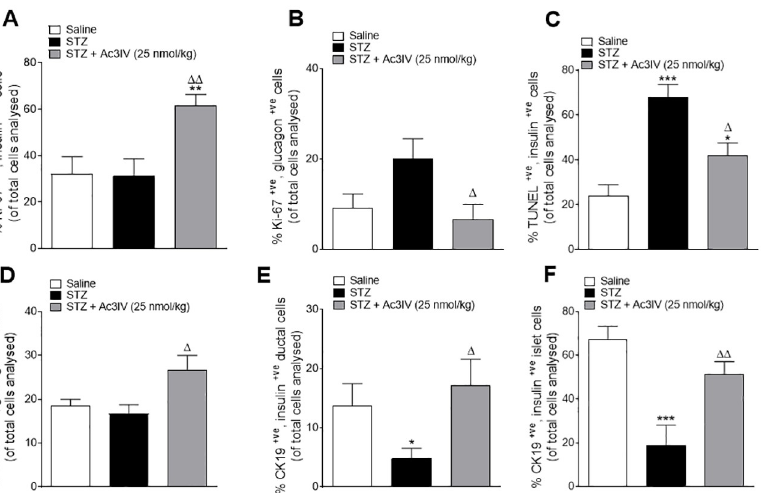
Fig 5. Effects of Ac3IV treatment on islet cell turnover and expression of ductal cell markers in STZ-diabetic Ins1Cre /+ Rosa26-eYFP mice. Parameters were assessed following 12 days twice-daily treatment with saline (0.9% NaCl) vehicle or Ac3IV (25 nmol/kg bw, i.p.) in STZ- diabetic Ins1Cre /+ Rosa26-eYFP transgenic mice. Beta- and alpha-cell proliferation (A,B) and apoptosis (C,D) were assessed by Ki67 or TUNEL co-staining with insulin/glucagon, respectively. CK-19 co-localisation with insulin in pancreatic ductal (E) and islet (F) cells. Values are mean ± SEM for n = 6 mice. � p < 0.05, �� p < 0.01, ��� p < 0.001 compared to saline vehicle. Δ p < 0.05 and ΔΔ p < 0.01 compared to STZ- diabetic